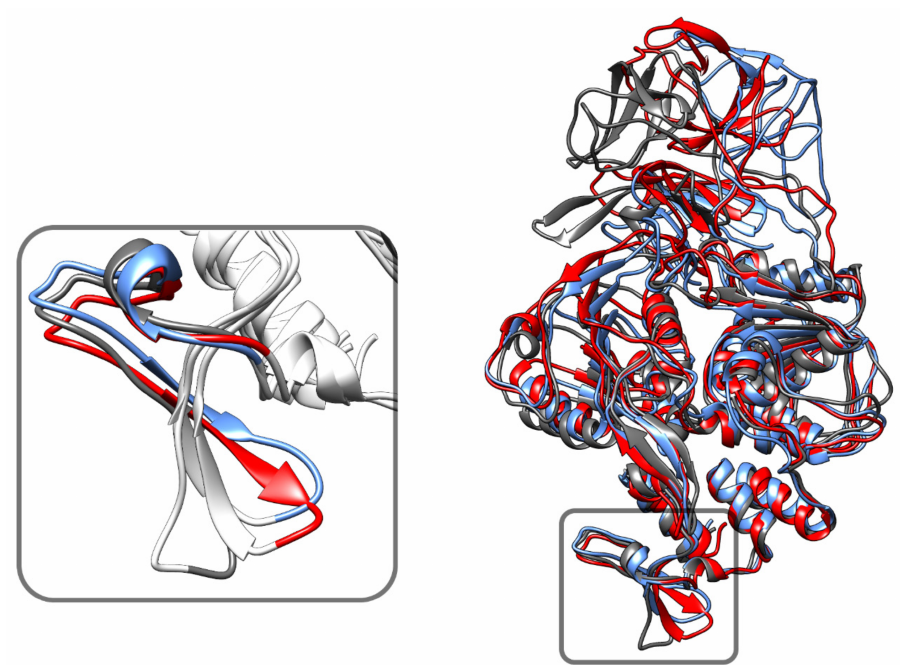
Figure 8. Site-specific changes in NS3 structure with phosphorylation. The C-terminal amino acid residues are essential for the interaction of NS3 with NS5. The three simulated structures at time 100 ns (gray—WT, red—S137, blue—T189). WT residues 566–585 (inside the box) show an apparent shape and position difference from